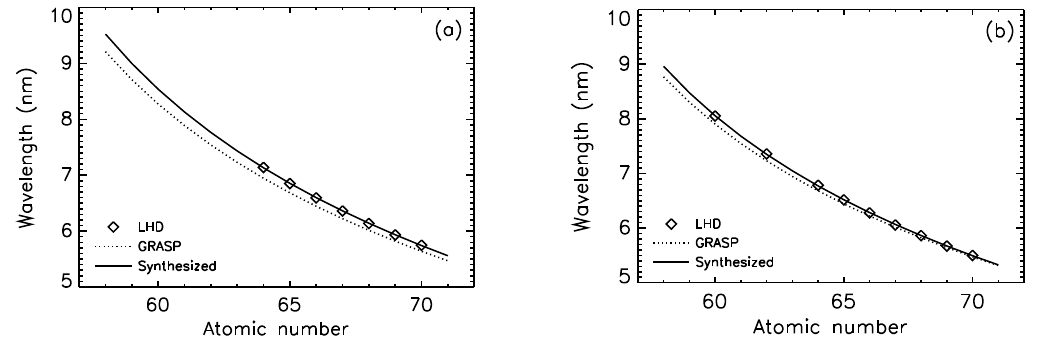
Figure 2. Atomic number dependences of the wavelengths for the transitions ( a ) 4d 10 4f 2 F 7/2 –4d 9 4f 2 2 G 10 1 S 9 4f 1 P 0 –4d 1 of Pd-like ions. The wavelengths measured in the 9/2 of Ag-like ions and ( b ) 4d LHD are plotted with diamond symbols, while those calculated by GRASP92/RATIP are drawn with dotted lines. Solid lines denote the wavelengths synthesized with the fitting (see the text in Section 5 for